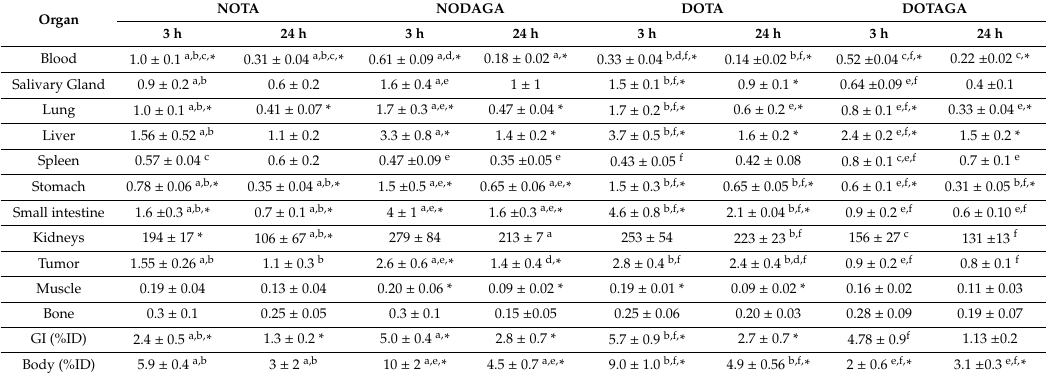
Table 3. Ex vivo biodistribution. Female Balb/c nu/nu mice with HER3-expressing BxPC-3 xenografts were injected with 2 µ g [ 57 Co]Co-(HE) 3 -Z HER3 -X (X = NOTA, NODAGA, DOTA,